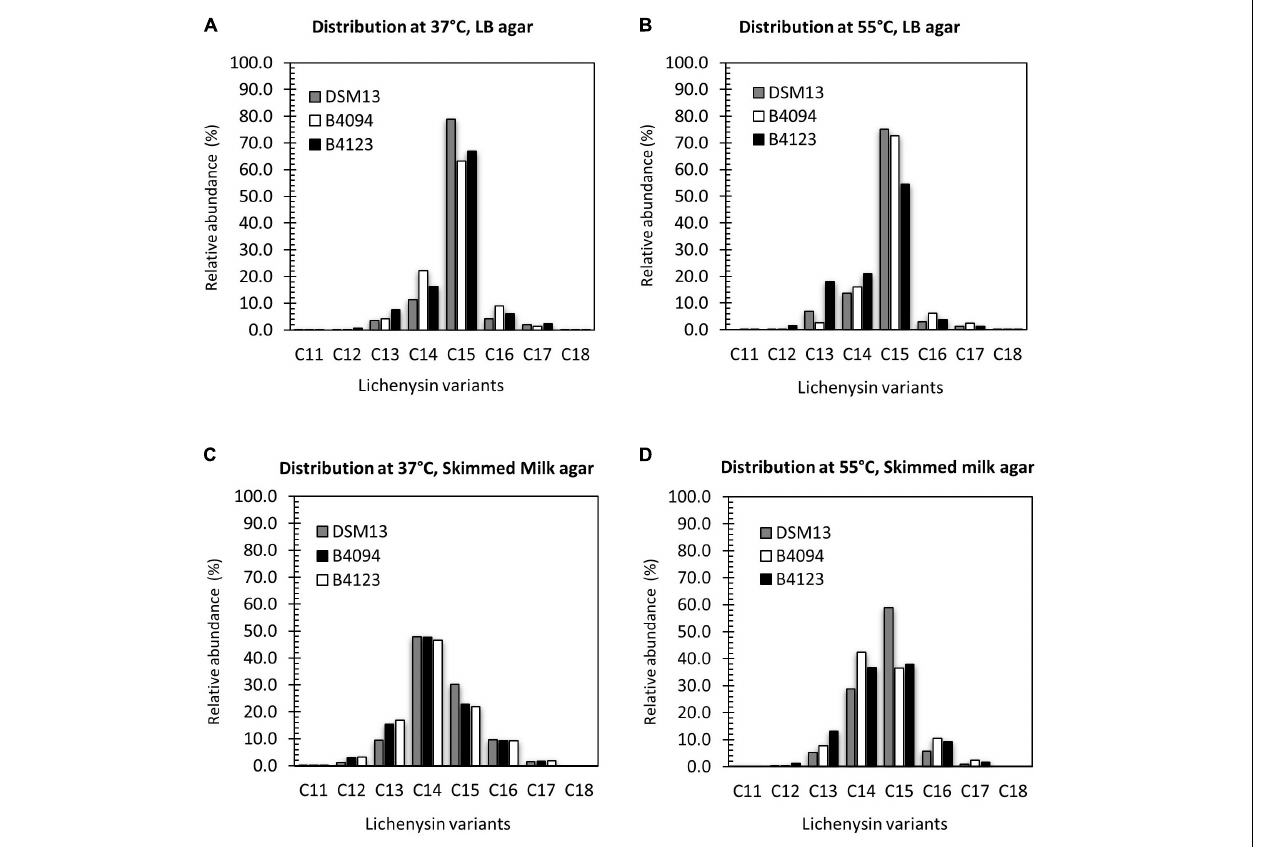
FIGURE 6 | Distribution of lichenysin A variants upon surface growth on LB agar and skimmed milk agar at 37 and 55 ◦ C. Relative abundance of individual lichenysin variants as part of the total amount extracted from biomass of DSM13 T , B4094, and B4123 after 10 days of incubations on (A) LB agar at 37 ◦ C; (B) LB agar at 55 ◦ C; (C) skimmed milk agar at 37 ◦ C; (D) skimmed milk agar at 55 ◦ C. Gray bar- DSM13 T , white bar- B4094, black bar- B4123.